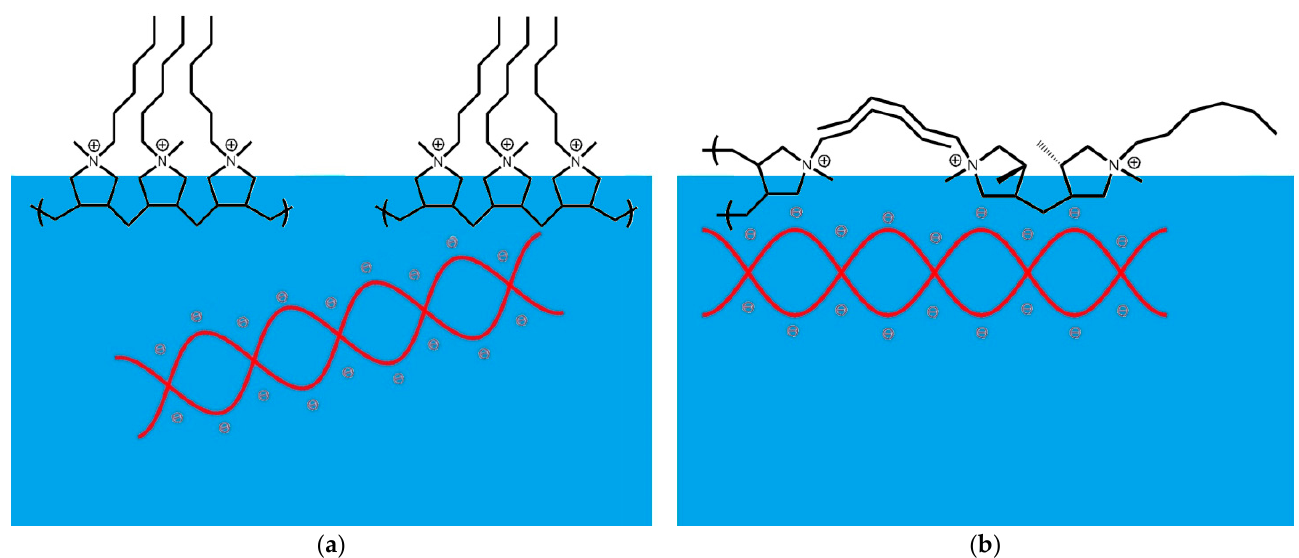
Figure 8. A scheme of inferred DNA interactions with a PDAHMAC layer at surface pressures in the region of a two- dimensional phase transition ( a ) and below this region ( b ) prior to aggregate formation.